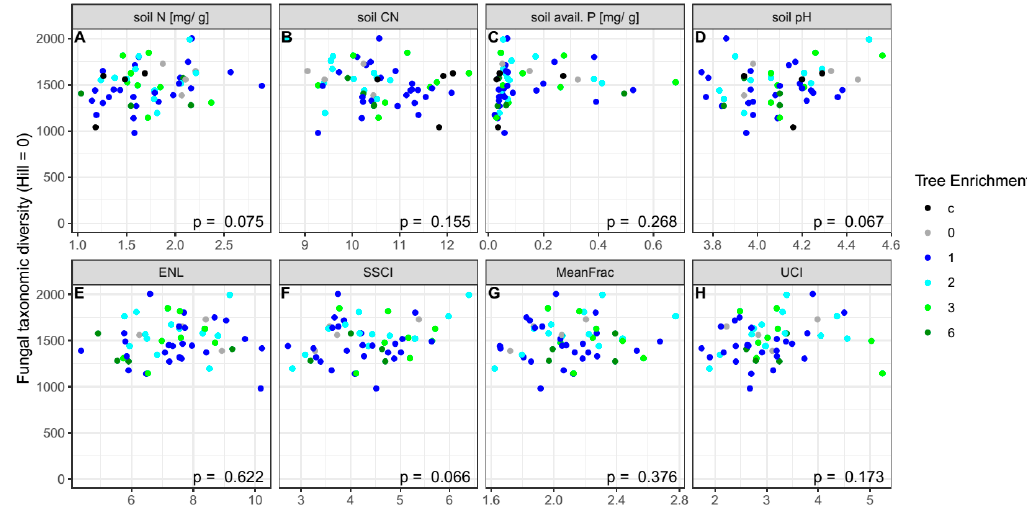
Figure 1. Relationship between fungal taxonomic diversity (expressed as Hill number with dimension 0) and soil abiotic variables (( A ): nitrogen, ( B ): carbon-to-nitrogen ratio, ( C ): available phosphorus, ( D ): pH), as well as different components of vegetation structural complexity (( E ): effective number of layers (ENL), ( F ): stand structural complexity index (SSCI), ( G ): mean fractal dimension of polygons resulting from cross-sections in the point cloud (MeanFRAC), ( H ): understory complexity index (UCI)). N: nitrogen, C/N: carbon-to-nitrogen ratio, P: phosphorus. Linear models were fitted to the data. No significant relationships (F-test in ANOVA, p -value < 0.05) were found. Colors denote tree richness; c: oil palm control plots with management as usual.